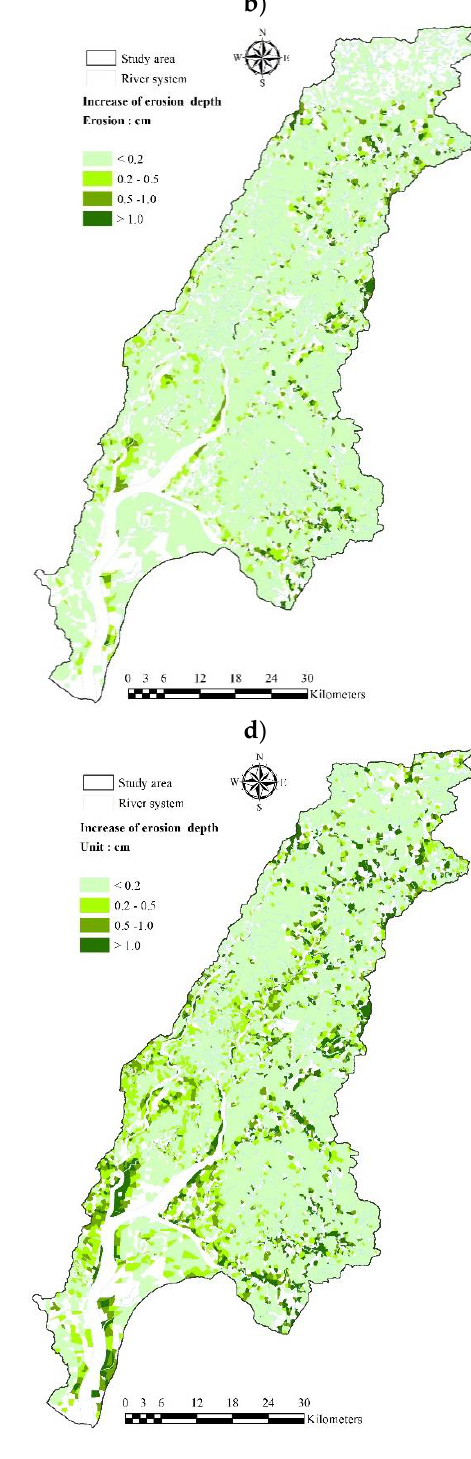
Figure 16. Spatial distribution of erosion depth increase under the influence of climate change under ( a ) 10 year, ( b ) 25 year, ( c ) 100 year and ( d ) 200 year return periods. ( a ) 10 year, ( b ) 25 year, ( c ) 100 year and ( d ) 200 year return